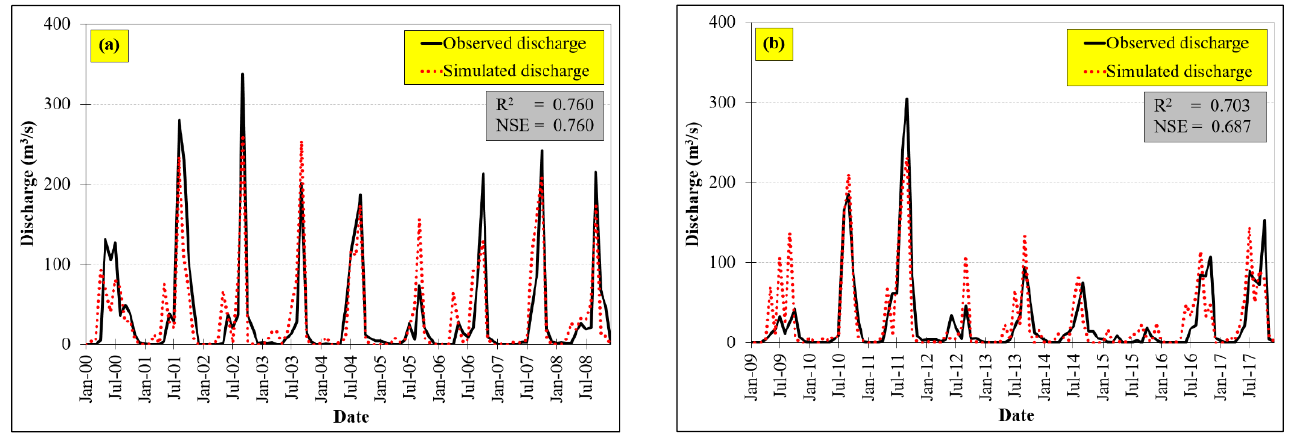
Figure 6. Observed and simulated monthly discharge during ( a ) calibration period and ( b ) validation period, at gauging station E.68A.